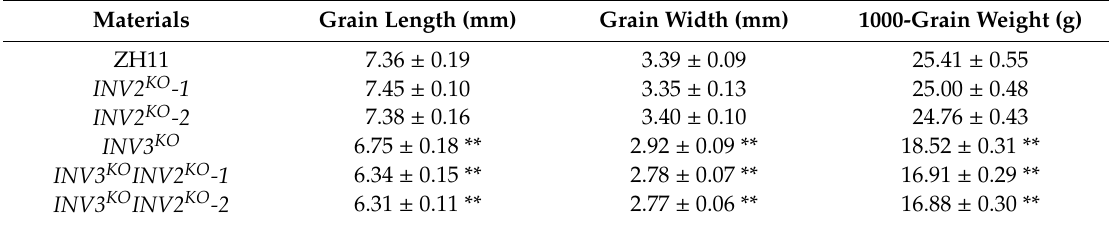
Table 3. Agronomic traits of ZH11 and KOs .